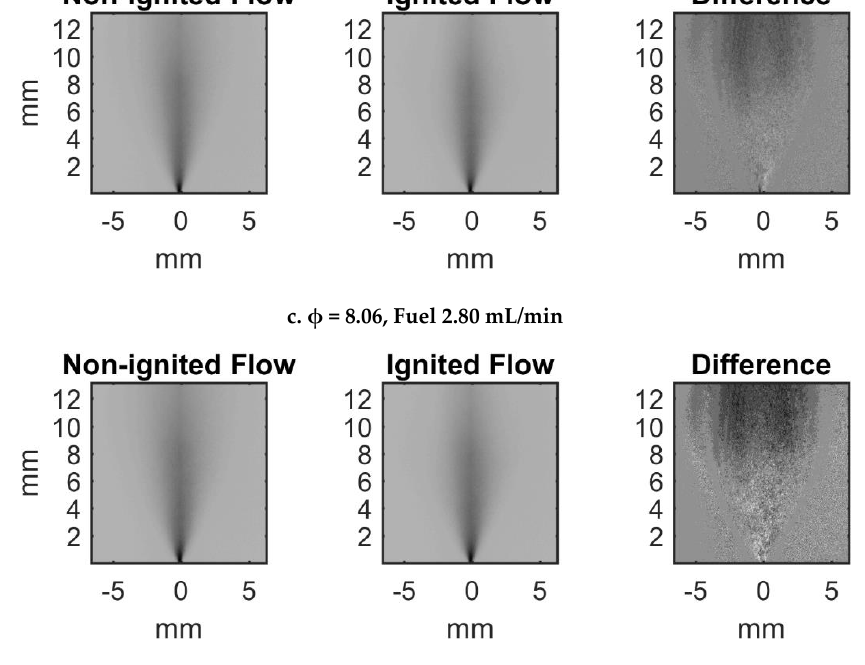
Figure 5. Shadowgraph images of ethanol spray at four equivalence ratios. Shadowgraphs are averaged from 100 sequential shots. The O 2 flow rate was fixed at 0.4 L/min.